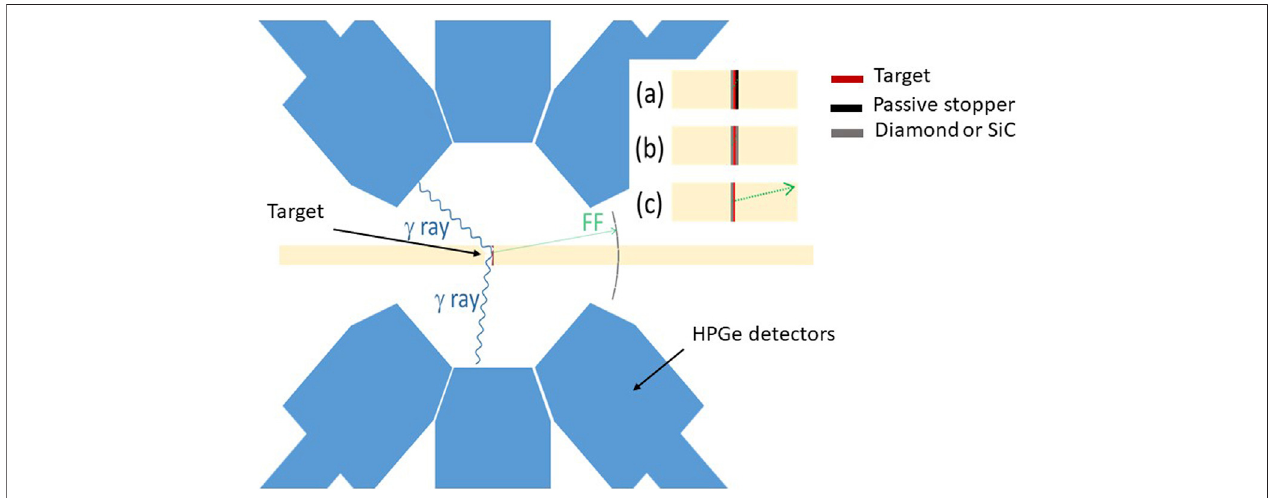
FIGURE 13 | FIPPS detector schematic. Three possible con fi gurations for a target (red) and FF detector (grey) arrangement. (A) Single-sided FF detection with a passive stopper (black) on the opposite side. (B) Double-sided FF detection. (C) Single-sided adjacent FF detector plus a distant FF detector wall on the opposite side.